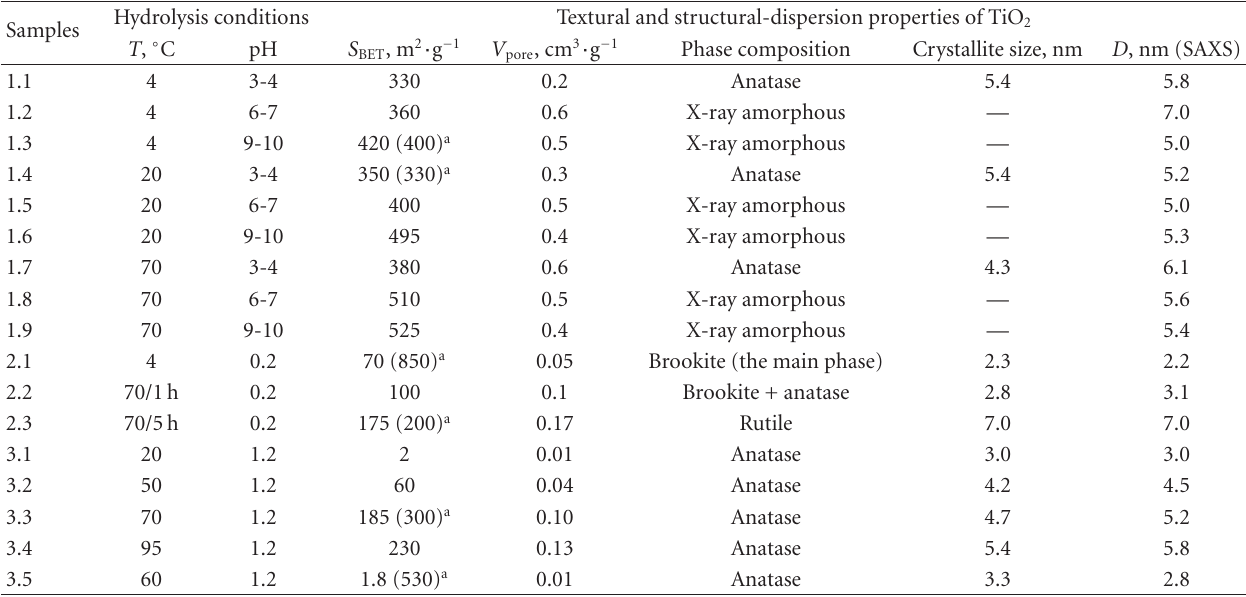
Table 1: Synthesis conditions of titanium dioxide samples and their properties.